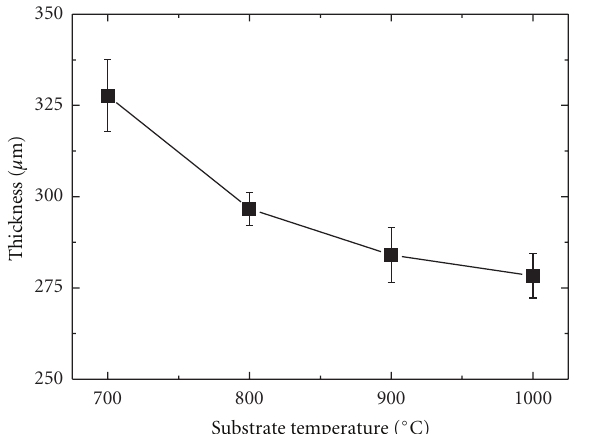
Figure 2: Thickness variation of ribbon-type Si wafers depending on the substrate temperature preheated at the range of 700–1000 ◦ C at the constant time interval of 2.5sec, moving velocity of the substrate of 485 cm/min, and blowing rate of Ar gas of 0.8 Nm 3 /h.